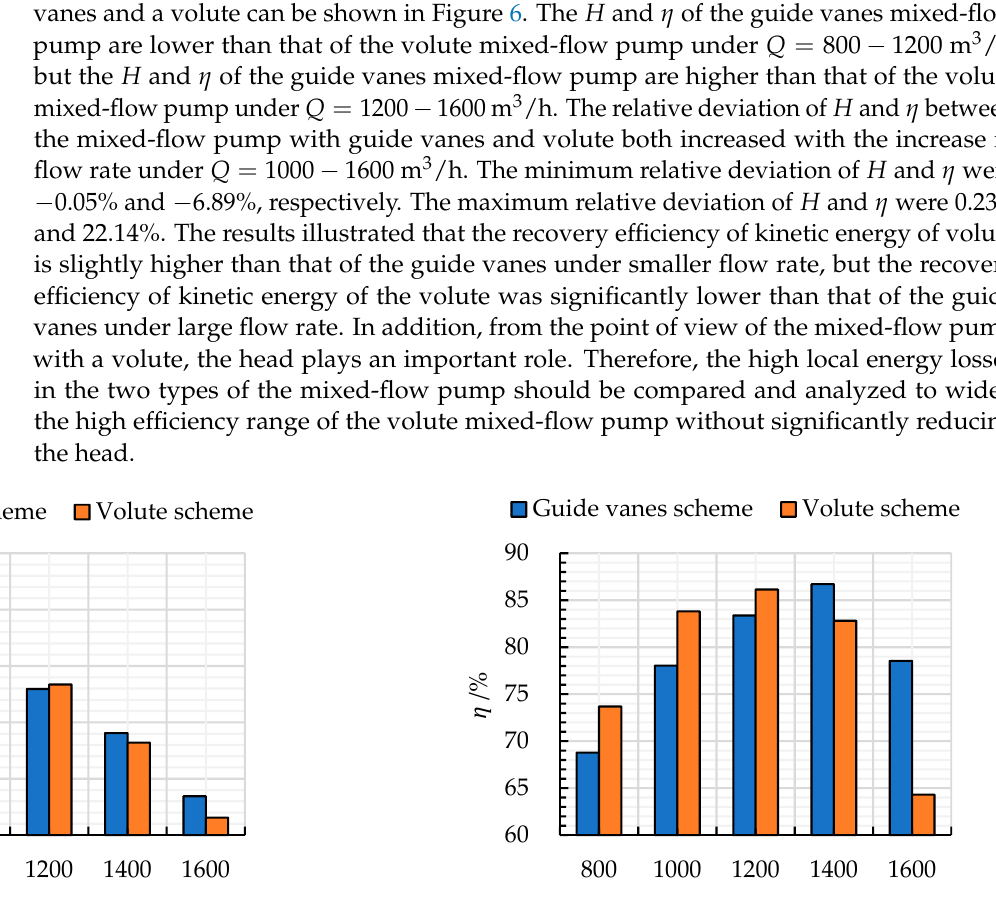
Figure 5. Comparison of test and calculated results of the mixed-flow pump with a volute.